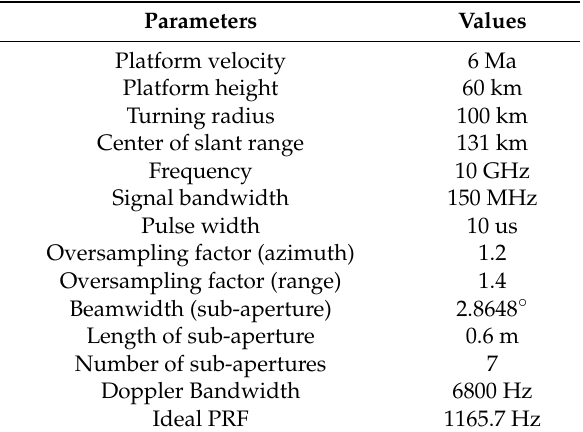
Table 1. Simulation parameters setting of SAR system.